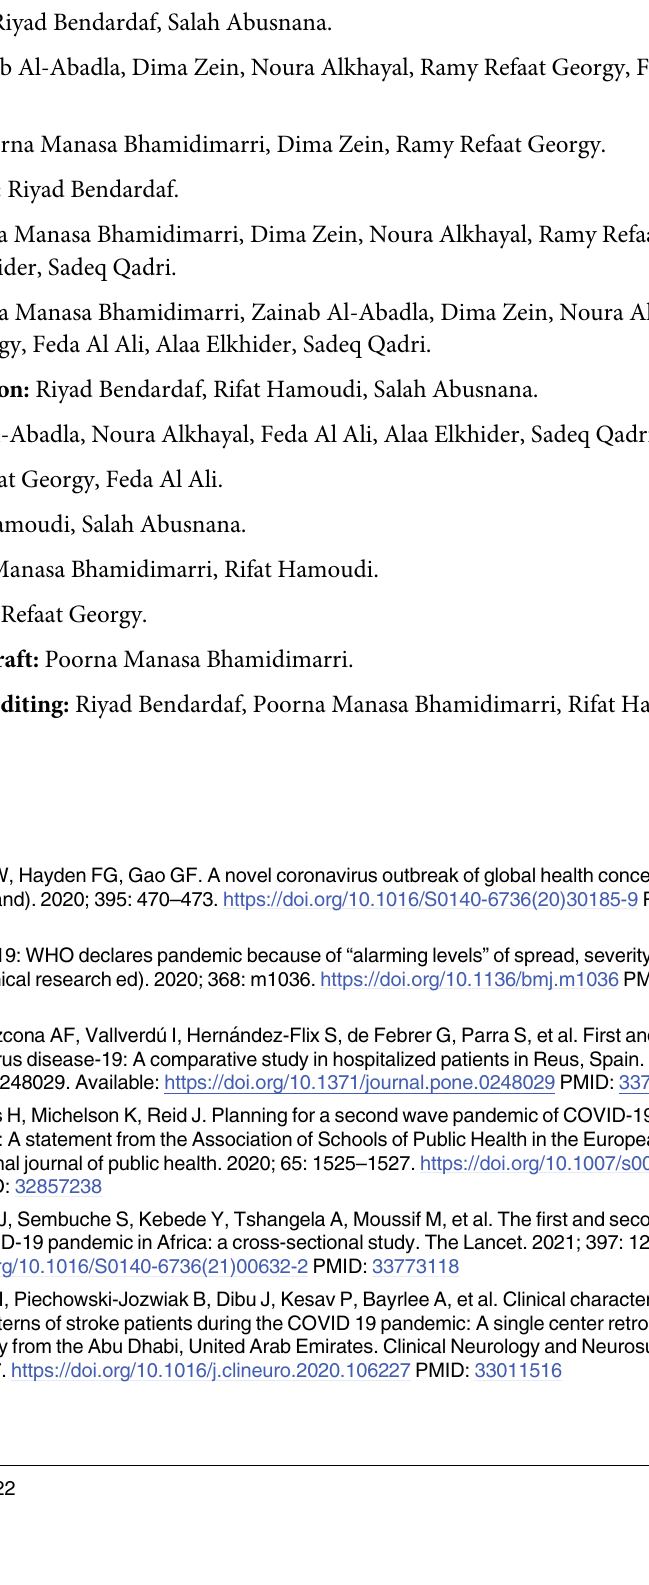
S2 Table. Treatment or clinical management for COVID-19 positive patients demarcated into non-ICU and ICU